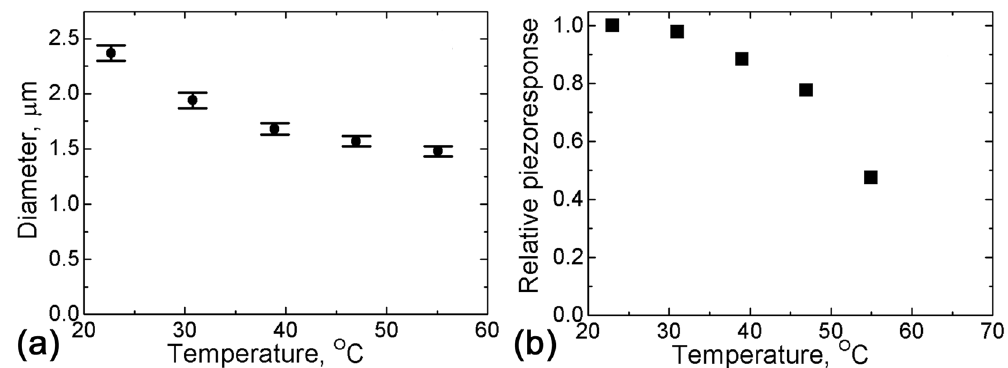
Figure 7. The temperature dependences of ( a ) the average diameter and ( b ) the relative PFM contrast of the circular domains created by discrete scanning in SBN61:Ce. U dc = 100 V, pulse duration 10